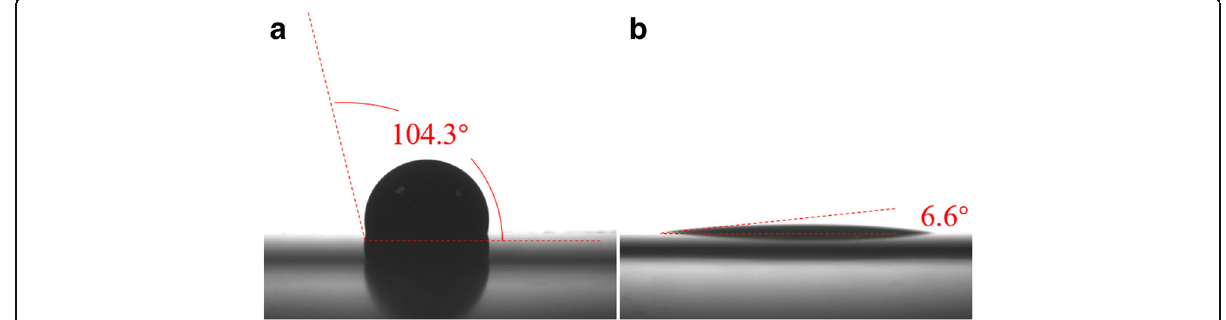
Fig. 2 The contact angle between wafer and PEDOT:PSS solution ( a ) without FS31 and ( b ) with FS31